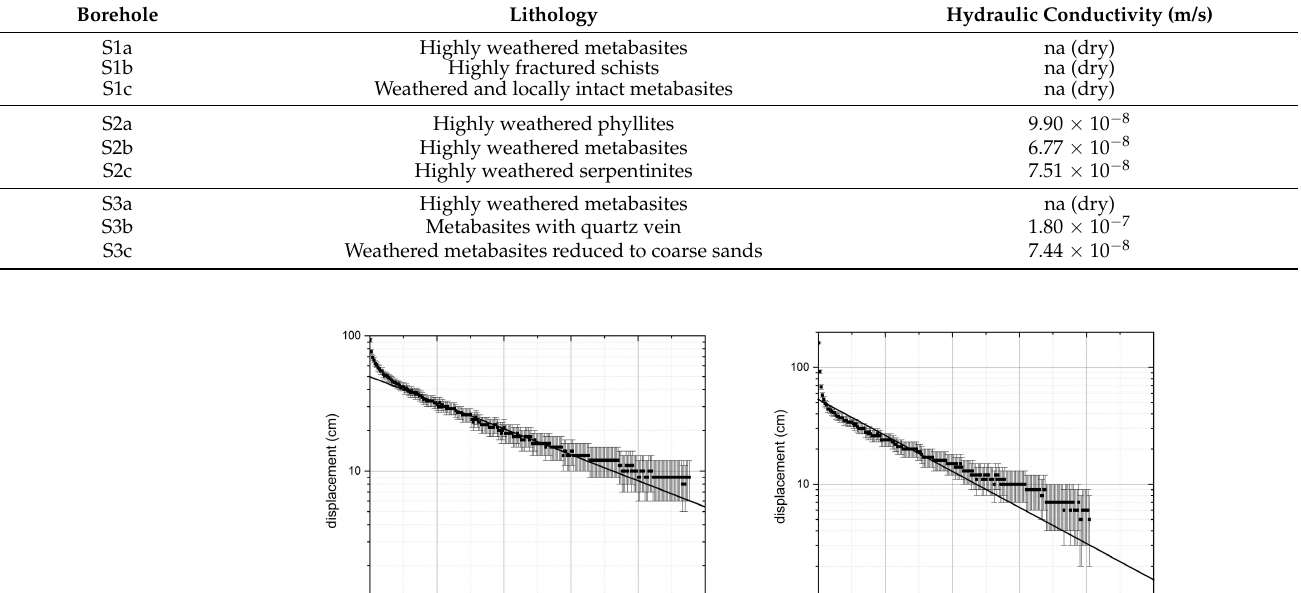
Table 2. Summary of the Slug Tests’ results carried out in different piezometers. The table shows the lithology and the hydraulic conductivity obtained with the Bouwer–Rice method.